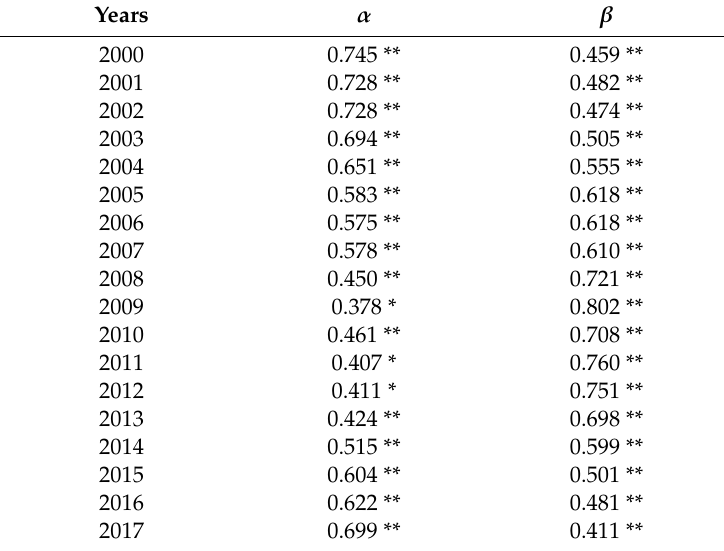
Table 2. Parameters of the Cobb–Douglas (C–D) function from 2000 to